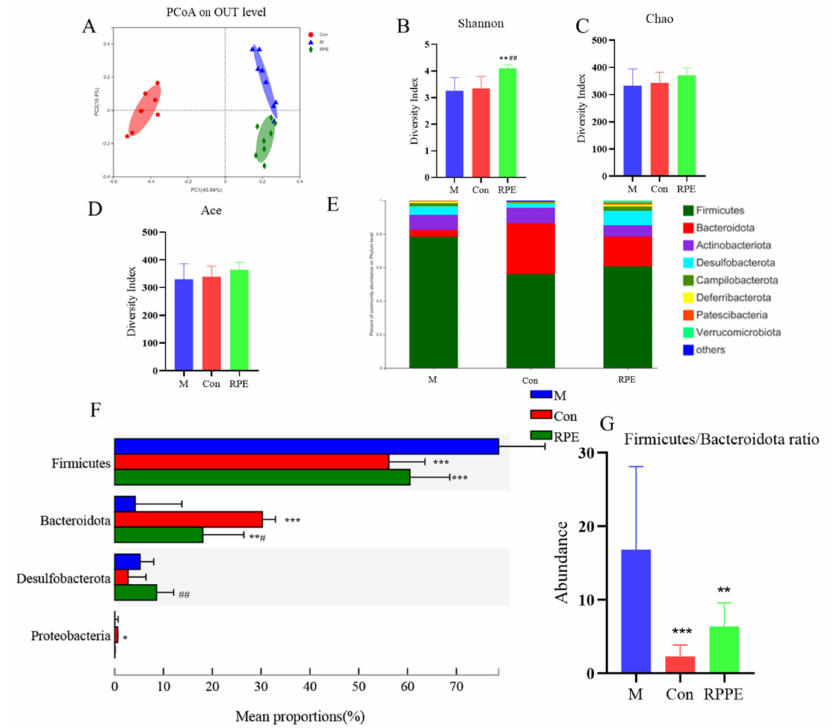
Figure 4. PCoA plot of gut microbiota at genus level ( A ). Shannon index ( B ). Chao index ( C ). Ace index ( D ). The components ( E ) and comparisons ( F ) of gut microbiota at phylum level. Firmi- cutes/Bacteroidota ratio ( G ) Note: * p < 0.05, ** p < 0.01, and *** p < 0.001 versus the M group; # p < 0.05, ## p < 0.01, and vs. the Con